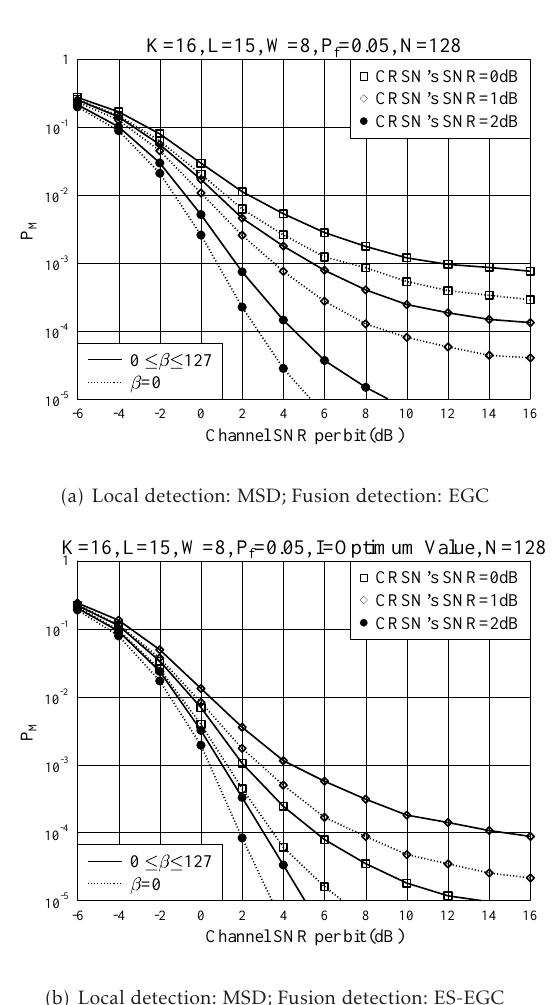
Figure 12. Overall missing probability of the cognitive SSN with the MSD for local detection and EGC or ES-EGC assisted fusion detection, when the CRSNs have various observation